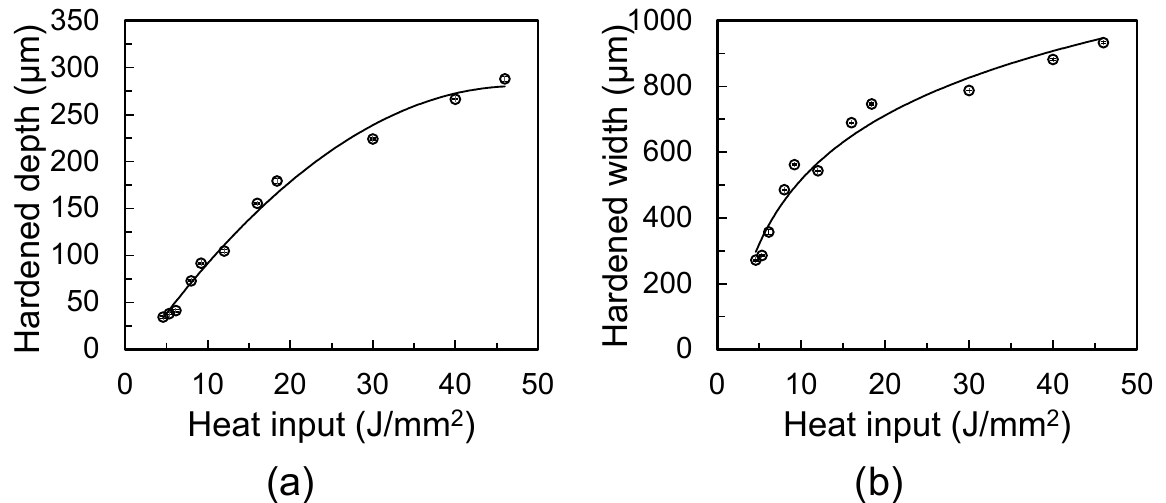
Figure 4. Graph showing the effect of heat input on the ( a ) depth of hardening; and ( b ) width of hardening.